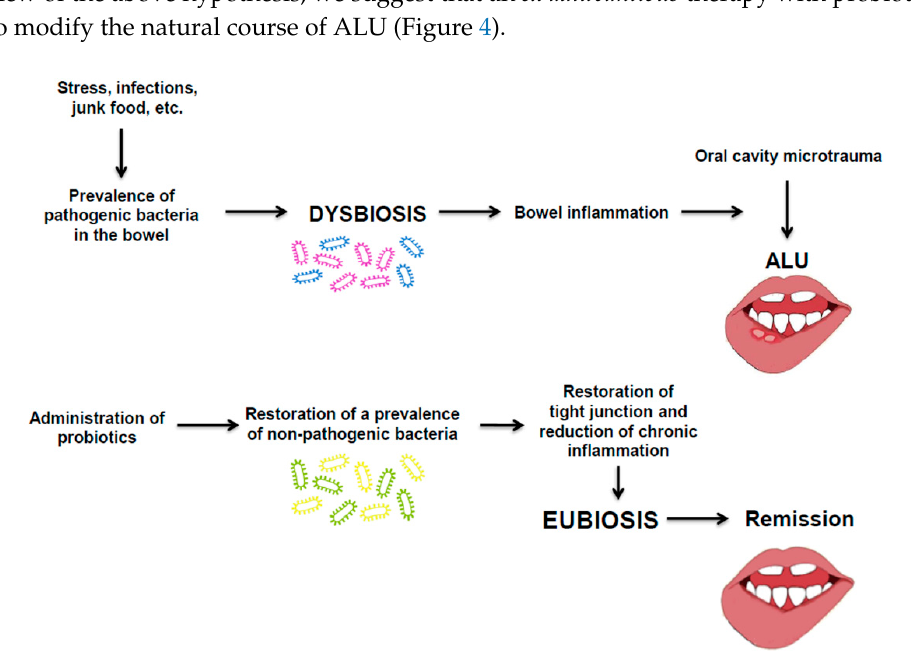
Figure 4. Probiotics as effective therapy for ALU. Restoration of eubiosis can dramatically contribute to remission of ALU by contrasting pathogenic phenomena. (Pathogenic bacteria are represented with purple frame, non-pathogenic with a blue frame; the yellow and green frame indicate the bacterial strains present after administration of probiotics)